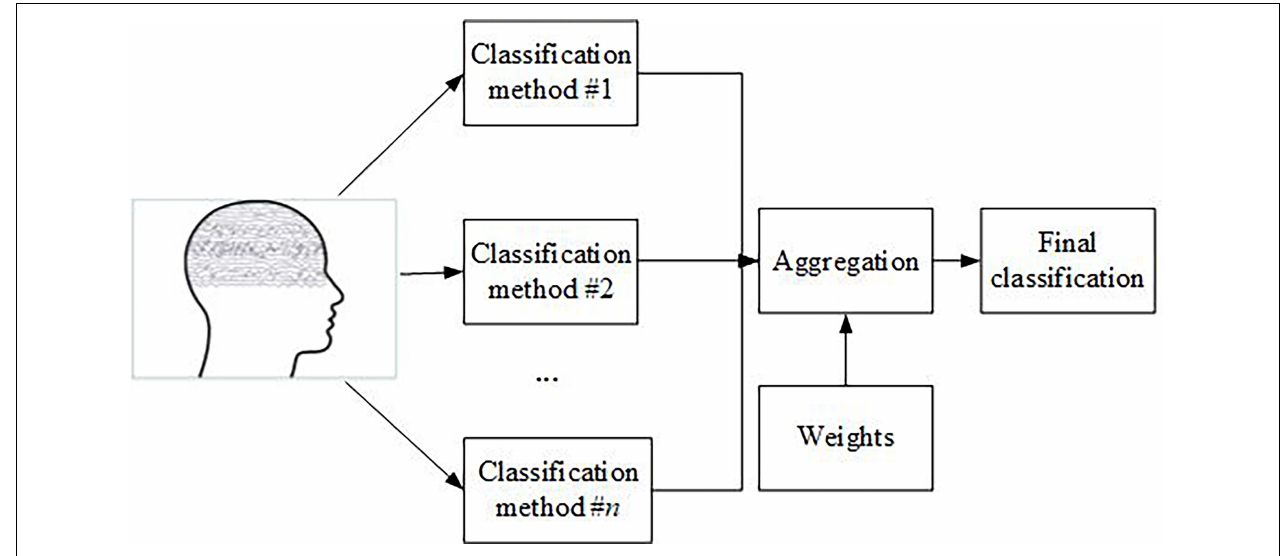
FIGURE 1 | A general classification scheme based on an aggregation